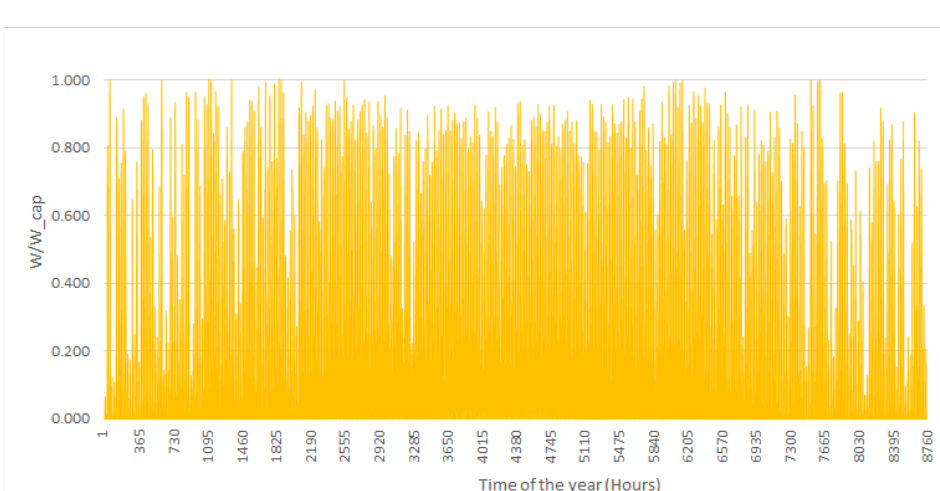
Figure 11. Yearly Watt per installed PV kWp.